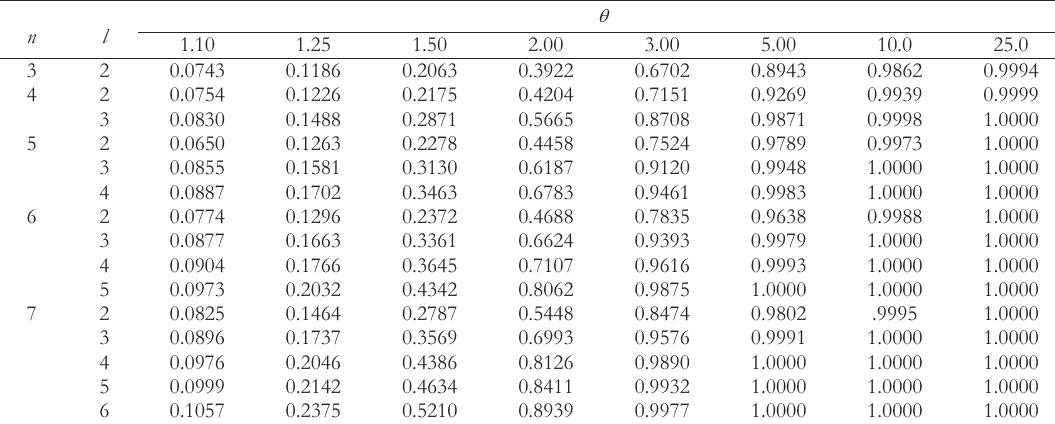
Power of Test 2 with SRSS data from the exponential distribution